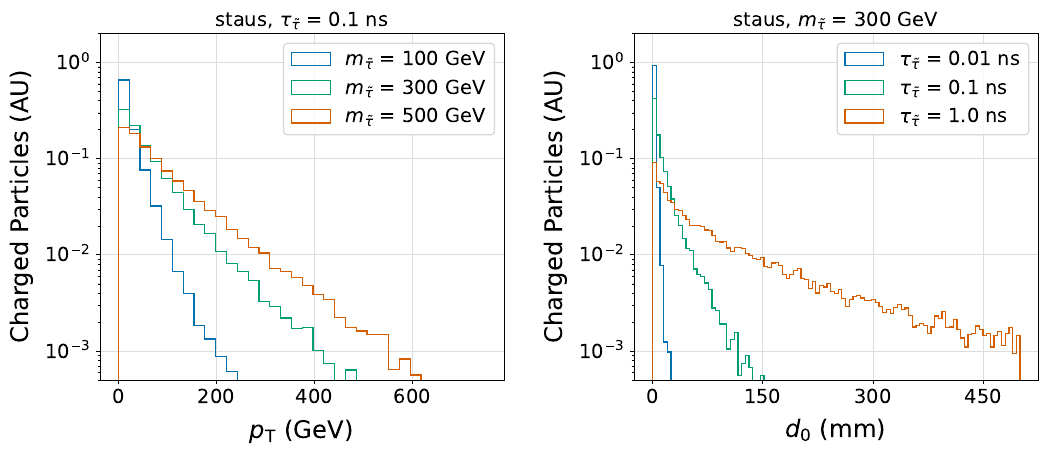
Figure 11. (Left) Displaced charged particle p T . Particles are required to be decay products of the long-lived stau. (Right) Displaced charged particle | d